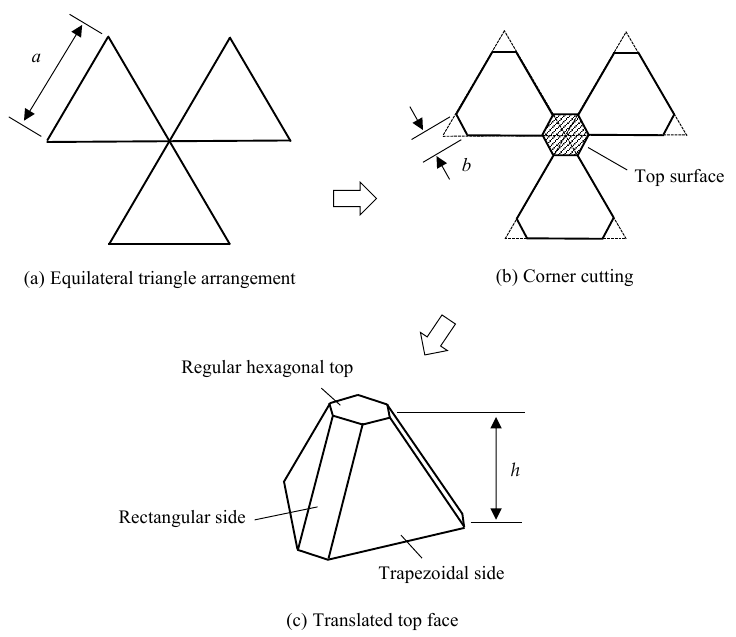
Figure 6. Design process of the truss core shape. The basic shape parameters are a , b , and h .